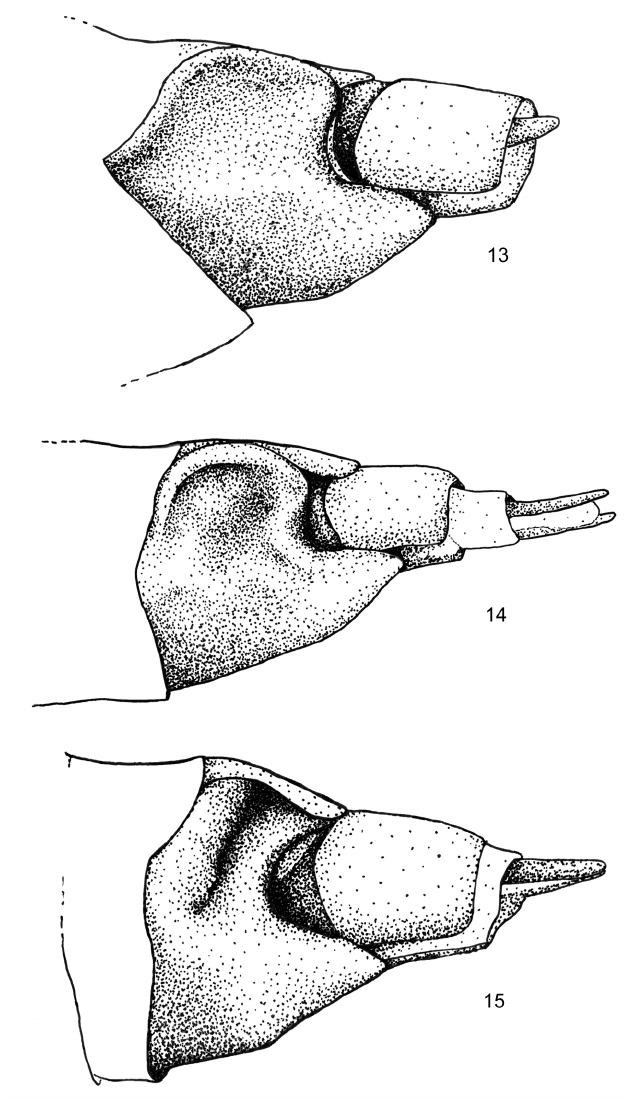
Figures 13–15. Rhabdorthodes females. Distal abdomen (scales removed), left ventrolateral aspect showing sculpted sternite A7. 13 R. pattersoni 14 R. durango 15 R. petersoni